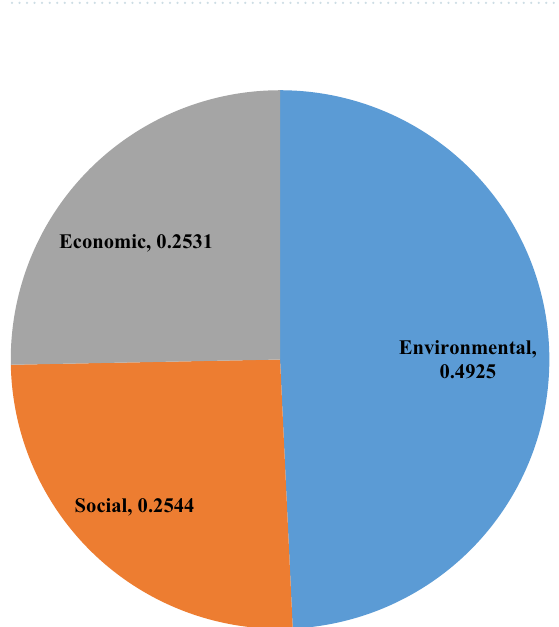
Table 17. Summarized comparative assessment of the developed model with extant tools.